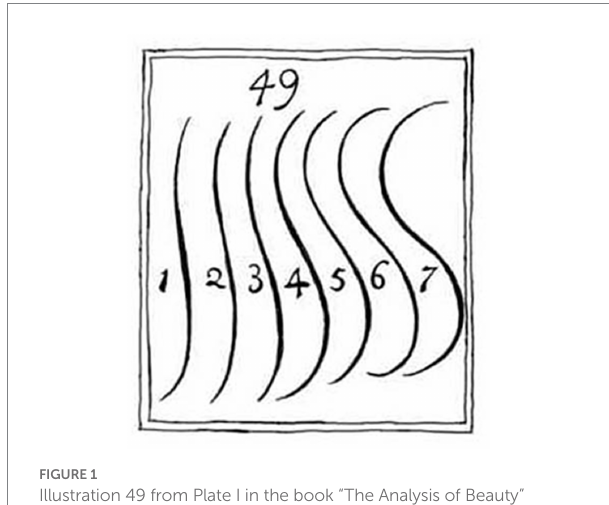
(Hogarth, 1753) (Copy downloaded from: https://commons. wikimedia.org/wiki/File:Serpentine_lines_from_William_